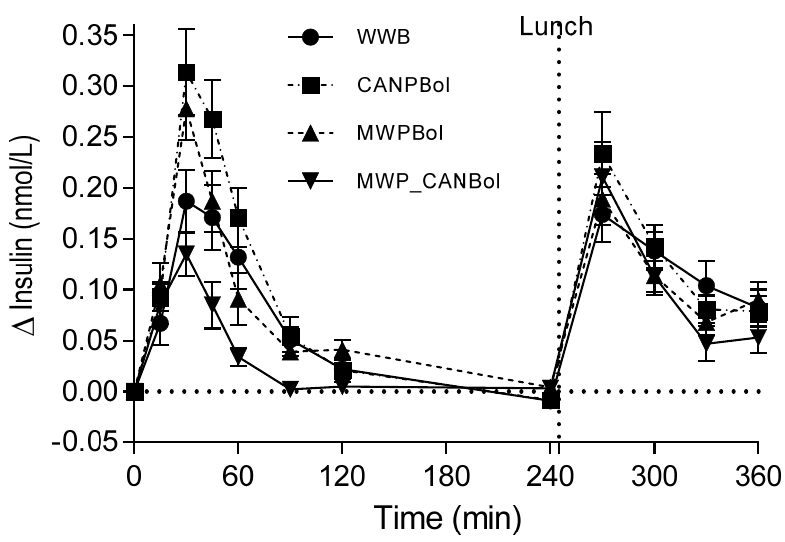
Figure 2. Mean (±SEM) changes in insulin response after the intake of the test meals and reference meal, and subsequent standardized lunch (Study 2).